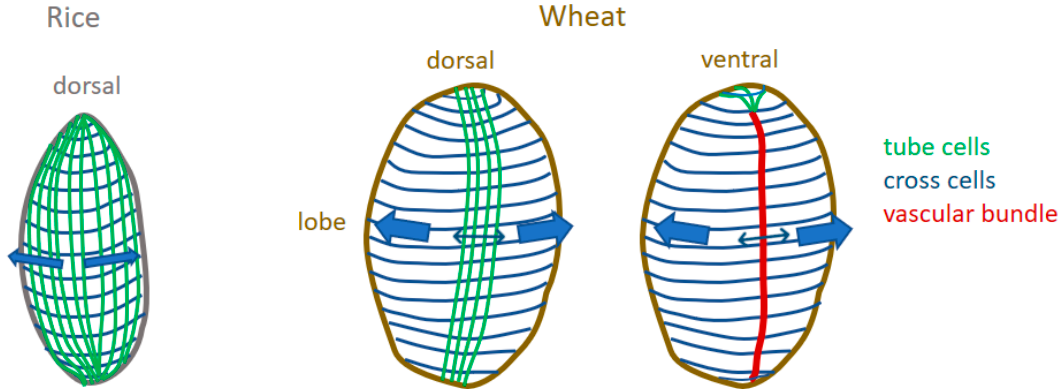
Figure 14. Schematic model of the putative function of endocarp in constraining growth. Within the rice caryopsis, cross cells and tube cells form a grid that covers the seed and would result in a uniform mechanical constraint. Within the wheat caryopsis, cross cells cover the whole surface of the seed while tube cells (and therefore the grid) are present only in the dorsal region. This could create local differences in mechanical properties, stiffer regions in the dorsal region and in the ventral region due to the vascular bundle, and “more” extensible regions in the lobes which could expand more.